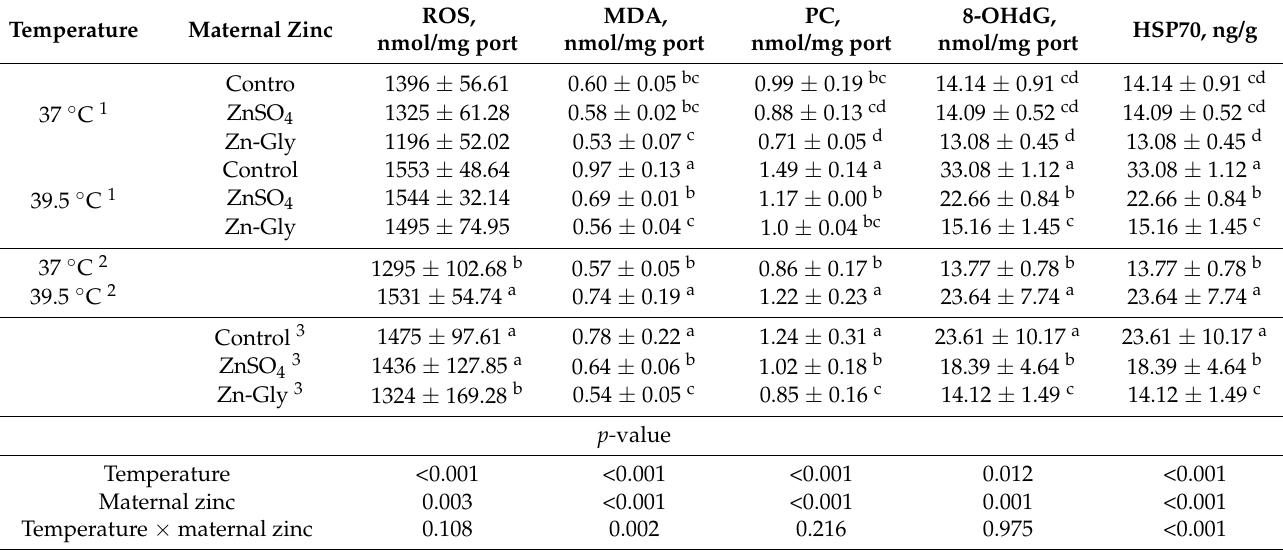
Table 4. Effects of maternal zinc on oxidative indicators and HSP70 in embryos under heat stress (mean ±